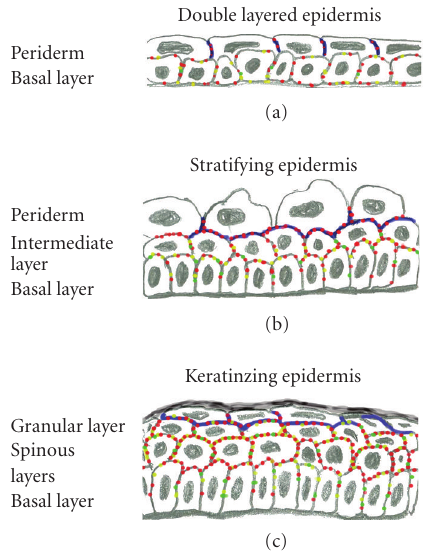
Figure 1: Schematic representation of developing human epider- mis. (a) Two cell layers, peridermal cells and basal cells at the first trimester (8 weeks). (b) Three cell layers at 11 weeks. The periderm cells become elevated. (c) By 21–24 weeks all the cell layers of mature epidermis are present. Tight junctions are shown in blue, desmosomes in red, adherens junctions in yellow, and green indicates gap junctions. The density of junctions increases during the